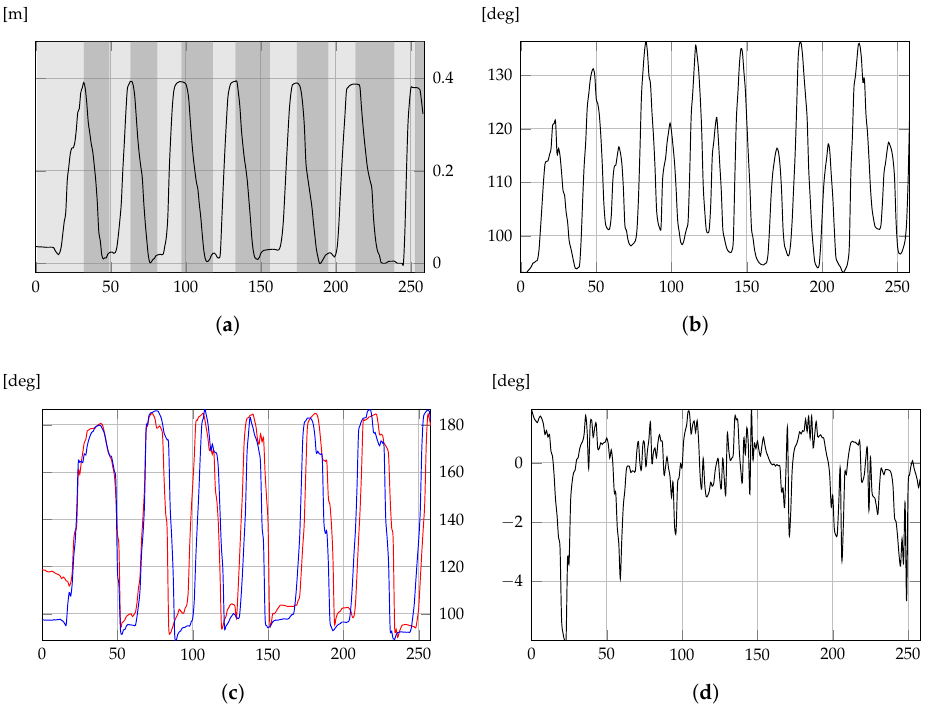
Figure 7. Graphs from Equilibrium Paint exergame. These graphic representations are available for clinical staff, so that deeper analysis is enabled throughout the whole session. ( a ) COM; ( b ) UBFA; ( c ) LLFA; ( d ) UBTA.